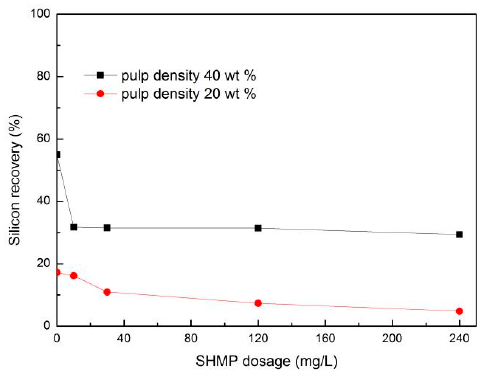
Figure 6. The silicon recovery for serpentine-ore flotation using SHMP at 40 wt % and 20 wt % pulp